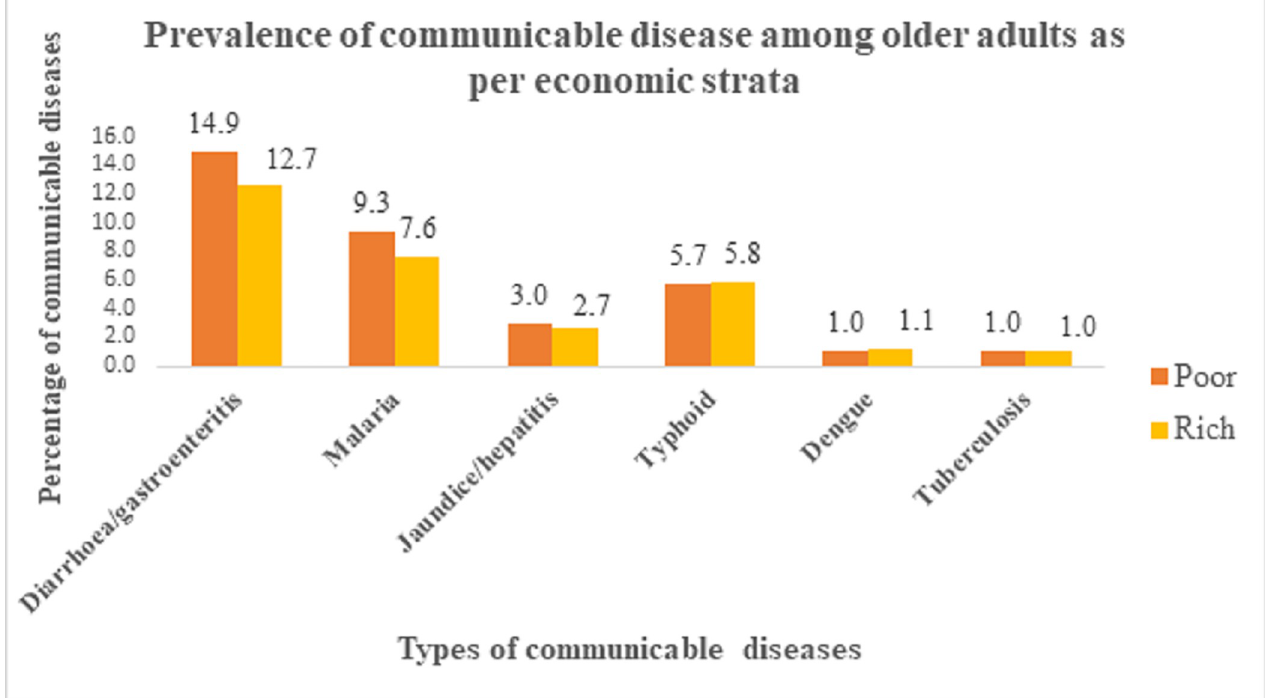
Fig 2. Percentage of communicable diseases among older adults as per economic